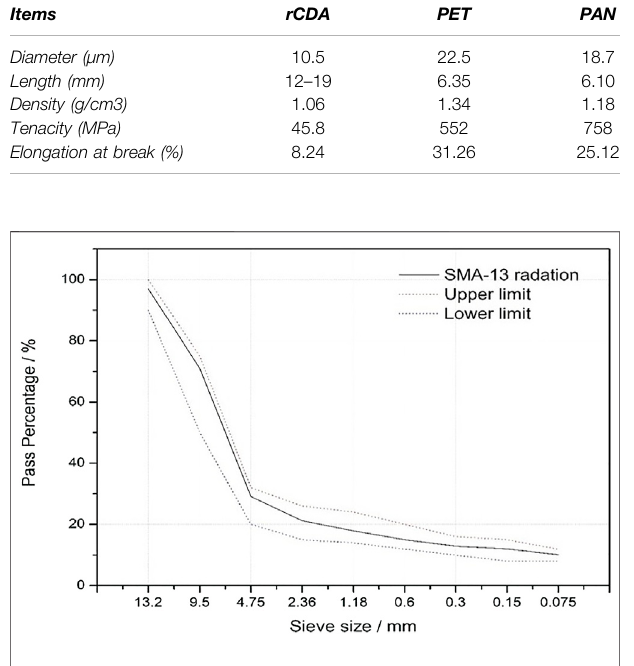
FIGURE 2 | A gradation curve for